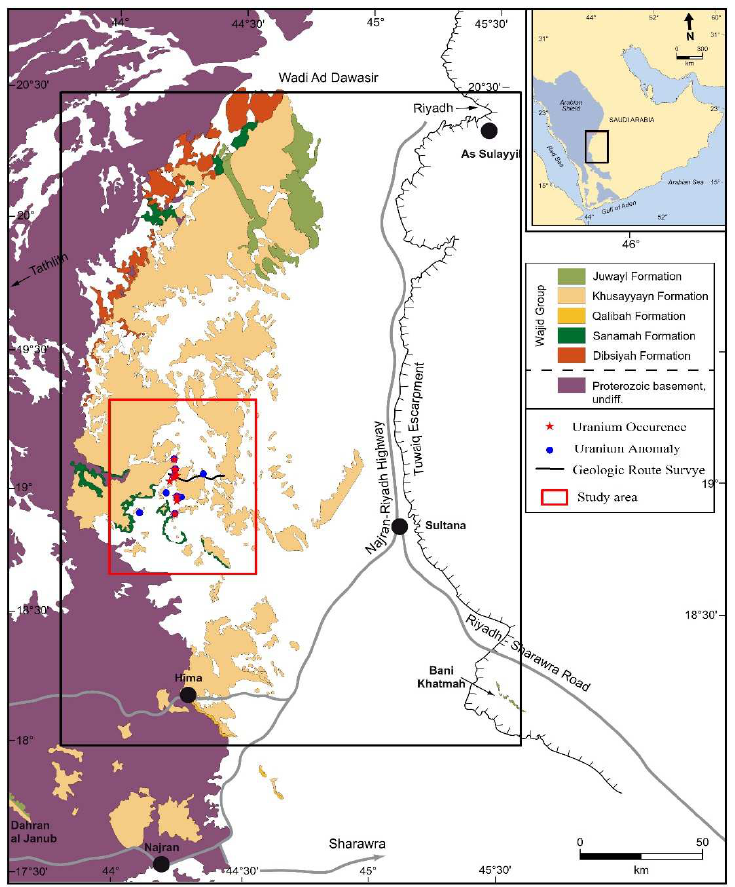
Figure 1. Geological map showing the Location of Wajid Group (after Al Ajmi, 2015 [26]). The study area is located in the eastern Wajid Basin adjacent to the south margin of the Arabian Shield in southern Saudi Arabia. The Proterozoic basements of Arabian Shield to the west are the possible uranium sources in the study area. The sedimentary cover of the Arabian plate is quite thick, with ages ranging from the infra-Cambrian to the Neogene [27,28]. The rifting of the Arabian Shield resulted in the easterly tilt of the Arabian Shield and the Arabian Platform [16,29,30]. The strata in the Wajid Basin dip eastward from the western basement, and the dip angle is only 1 to 5 degrees [15,31]. The dip